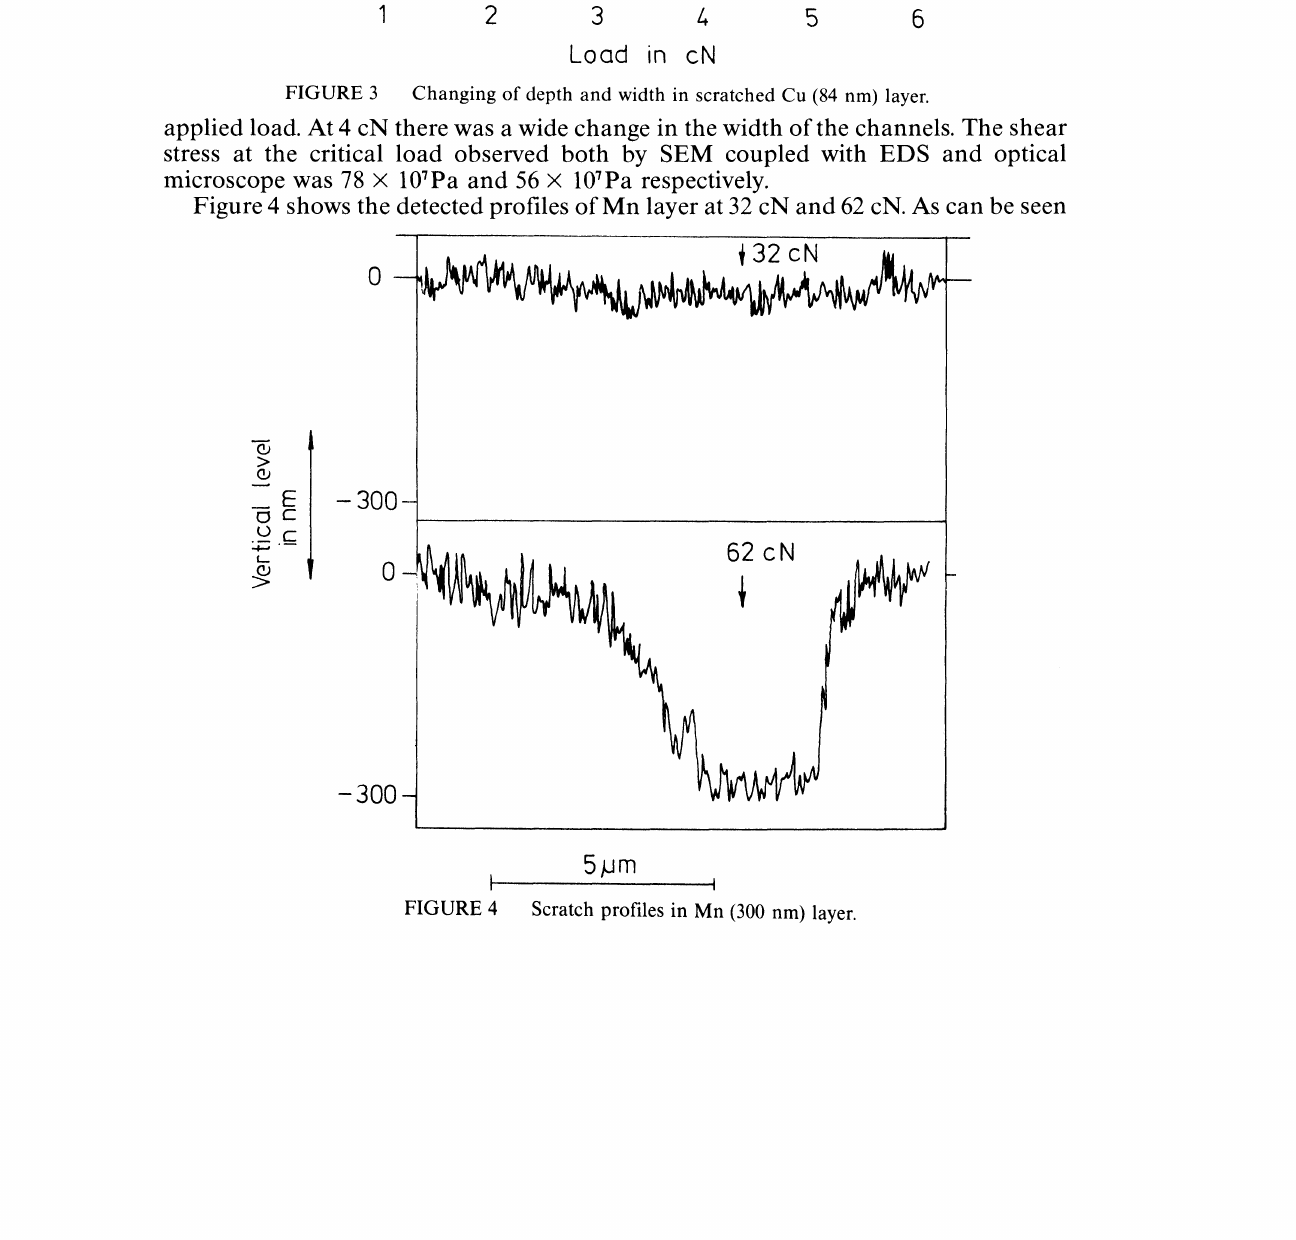
FIGURE 4 Scratch profiles in Mn (300 nm)